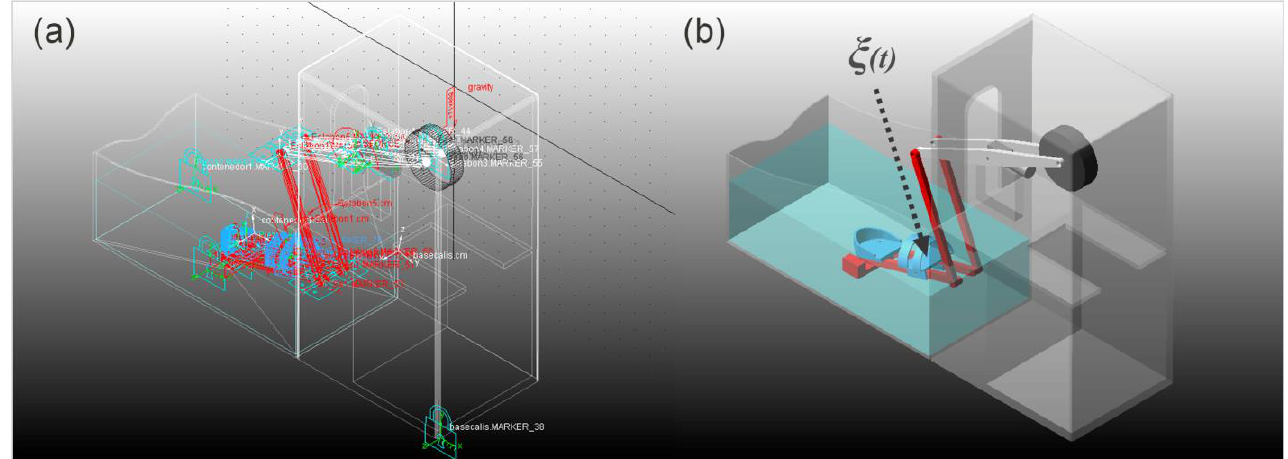
Figure 11. Virtual prototype. ( a ) Parts, workspace, and Cartesian coordinate system, and ( b ) robot simulation using MSC ADAMS/View ® .